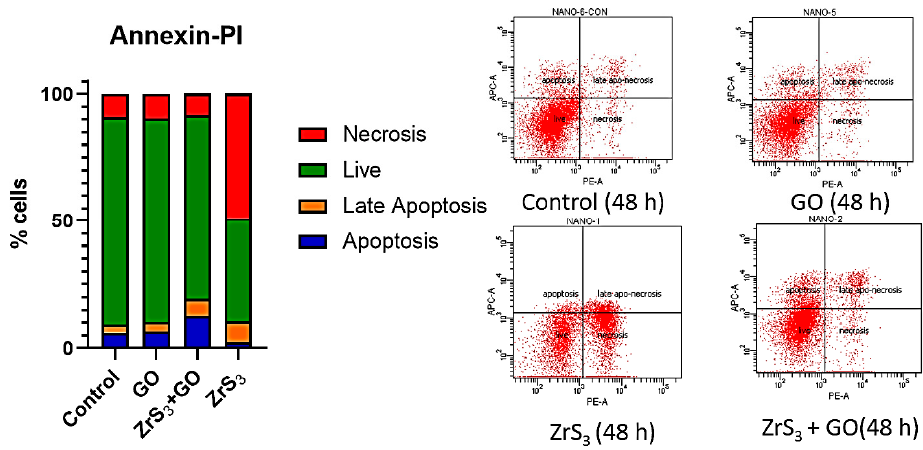
Figure 7. Annexin–PI assay of HCT116 cells on nanostructured films (control, GO, ZrS 3 , ZrS 3 +GO).